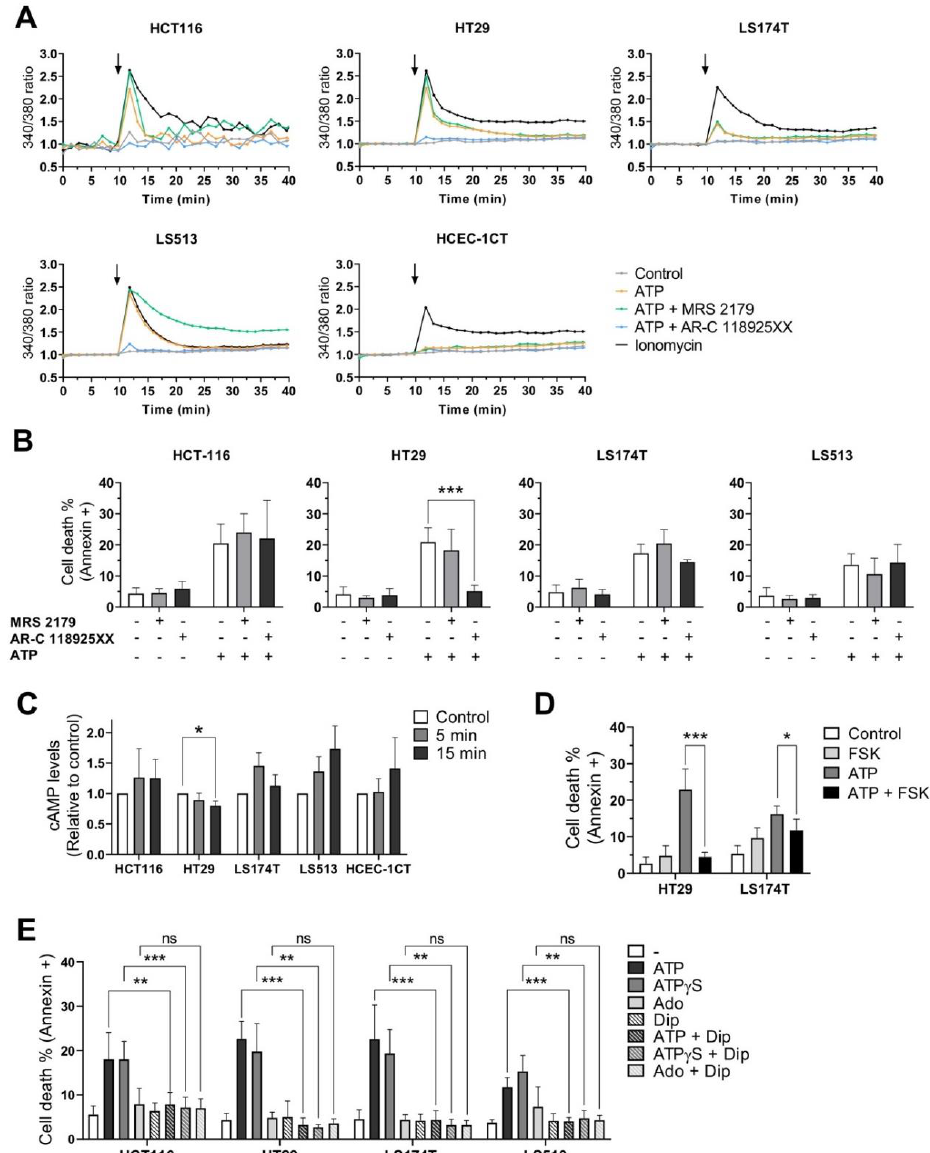
Figure 6. Ca 2+ mobilization and cAMP levels modulation in CRC cell lines induced by purine molecules. ( A ) Intracellular Ca 2+ mobilization measured by the Fura-2 AM dye in CRC (HCT116, HT29, LS174T, LS513) and non-tumorigenic colonic (HCEC-1CT) cells. Cells either were or were not pre-incubated with P2RY1 or P2RY2 inhibitors (MRS 2179, 10 µ M and AR-C 118925XX, 4 µ M, respectively). After 10 min, 250 µ M ATP or 1 µ M ionomycin (positive control) was added to our samples. Control means untreated cells (negative control). Arrows show the time of ATP/ionomycin injection. Data are expressed as the mean of four independent experiments. ( B ) CRC (HCT116, HT29, LS174T, LS513) cells were treated (+) or not ( − ) for 30 min with P2RY1 inhibitor (MRS 2179, 10 µ M) or P2RY2 inhibitor (AR-C 118925XX, 4 µ M). Cells were then incubated with 250 µ M ATP for 48 h. The percentage of dead cells (Annexin V+) was determined by flow cytometry. Data are expressed as the mean +/ − SD ( n ≥ 3). ( C ) cAMP levels were measured in CRC and normal-like colonic cells treated or not (Control) for 5 or 15 min with 250 µ M ATP. Data are expressed as the mean +/ − SD ( n = 4). ( D ) CRC (HT29, LS174T) cells were treated or not for 30 min with the Adenylyl cyclase activator (FSK, 100 µ M) and then incubated with 250 µ M ATP for 48 h. The percentage of dead cells (Annexin V+) was determined by flow cytometry. Data are expressed as the mean +/ − SD ( n = 4). ( E ) CRC (HCT116, HT29, LS174T, LS513) cells were treated or not for 30 min with Dipyridamole (Dip, 10 µ M) and then incubated with either 250 µ M ATP, 250 µ M non-hydrolysable ATP (ATP γ S) or 250 µ M Adenosine (Ado) for 48 h. The percentage of dead cells (Annexin V+) was determined by flow cytometry. Data are expressed as the mean +/ − SD ( n ≥ 4). In panels B, D and E, p values were calculated using Student’s paired t -test; in panel C, p -values were calculated using the Mann–Whitney test (* p < 0.05; ** p < 0.01; *** p <